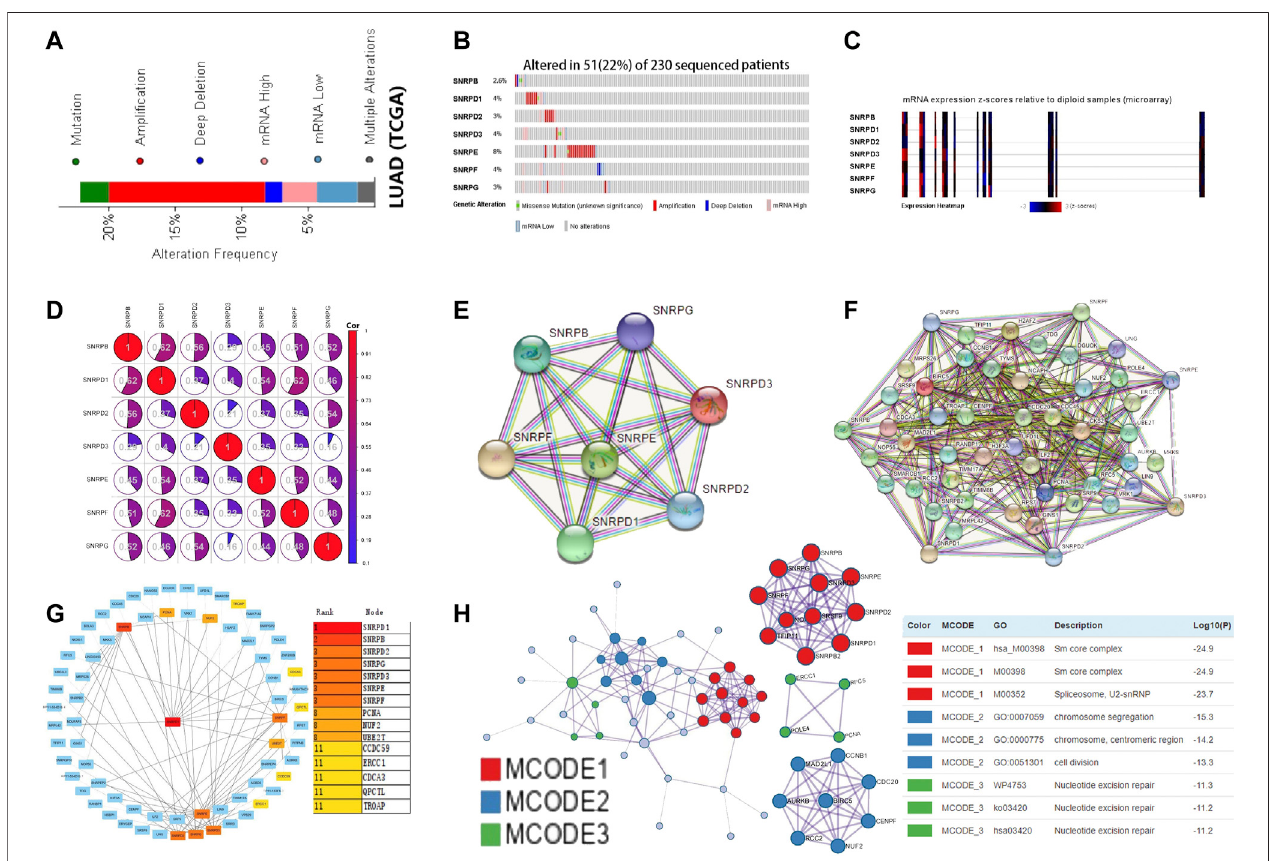
FIGURE 6 | Gene mutations, co-expression, and PPI network for genes for Sm proteins in LUAD (cBioPortal, STRING, Cytoscape, Metascape). (A – C) Gene mutationsandexpressionheatmapofgenesforSmproteinsinLUADpatients(cBioPortal). (D) Theco-expressionnetworkforgenesforSmproteins(cBioPortal). (E) PPI network based on the seven genes for Sm proteins (STRING). (F) PPI network based on genes for Sm proteins and their 50 neighbouring proteins (STRING). (G) Eight hub genes, including PCNA, NUF2, UBE2T, CCDC59, ERCC1, CDCA3, QPCTC, and TROAP, are shown in the PPI network (Cytoscape). (H) Protein-protein interaction network and MCODE components identi fi ed in different expressed genes for Sm proteins and 50 most frequently altered neighboring genes (Metascape).